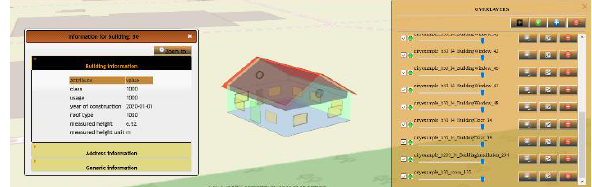
Figure 14. Building, address and generic information. Styling